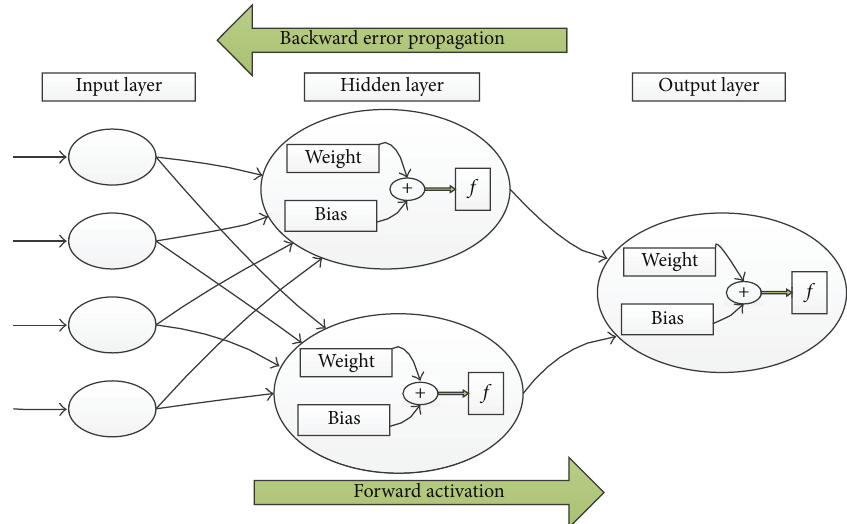
Figure 3: Working mechanism of artificial neural